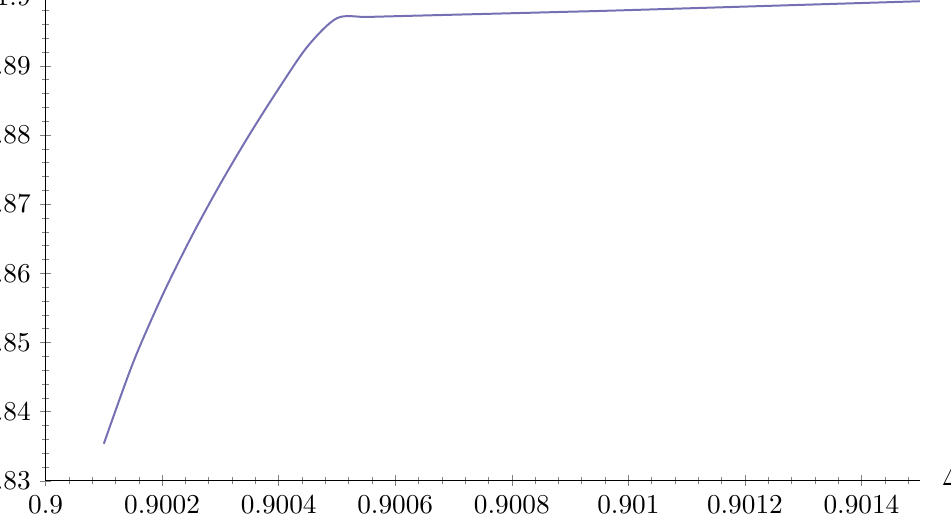
Figure 15 . Upper bound on the dimension of the (cid:12)rst singlet scalar in the (cid:30) i (cid:2) (cid:30) j OPE as a function of the dimension of (cid:30) in the O (3) model in d = 3 :